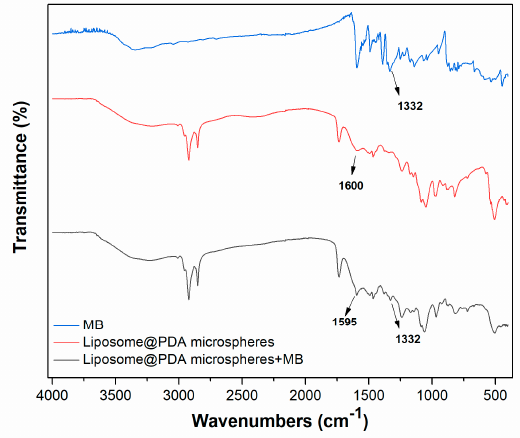
Figure 4. FTIR spectra of MB and Liposome@PDA microspheres before and after adsorption of MB.